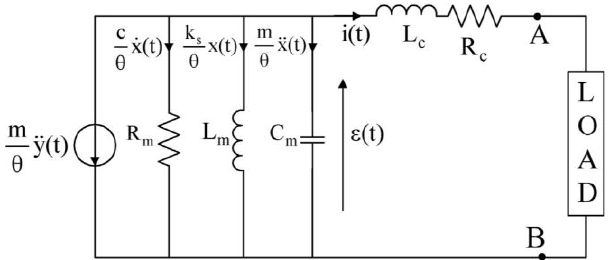
Figure 8. An analytical circuit model in [66], which analytically determined the effects of a bridge rectifier on an electromagnetic harvester system.